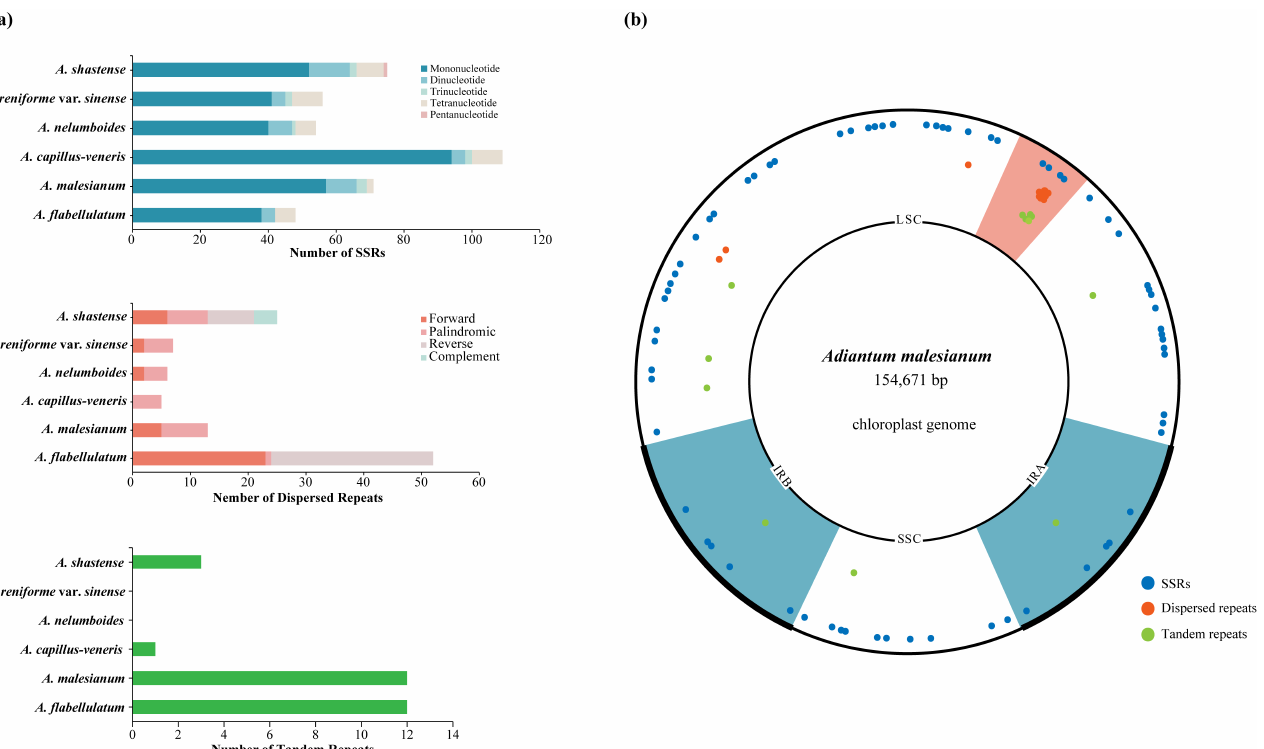
Figure 4. Figure 4.